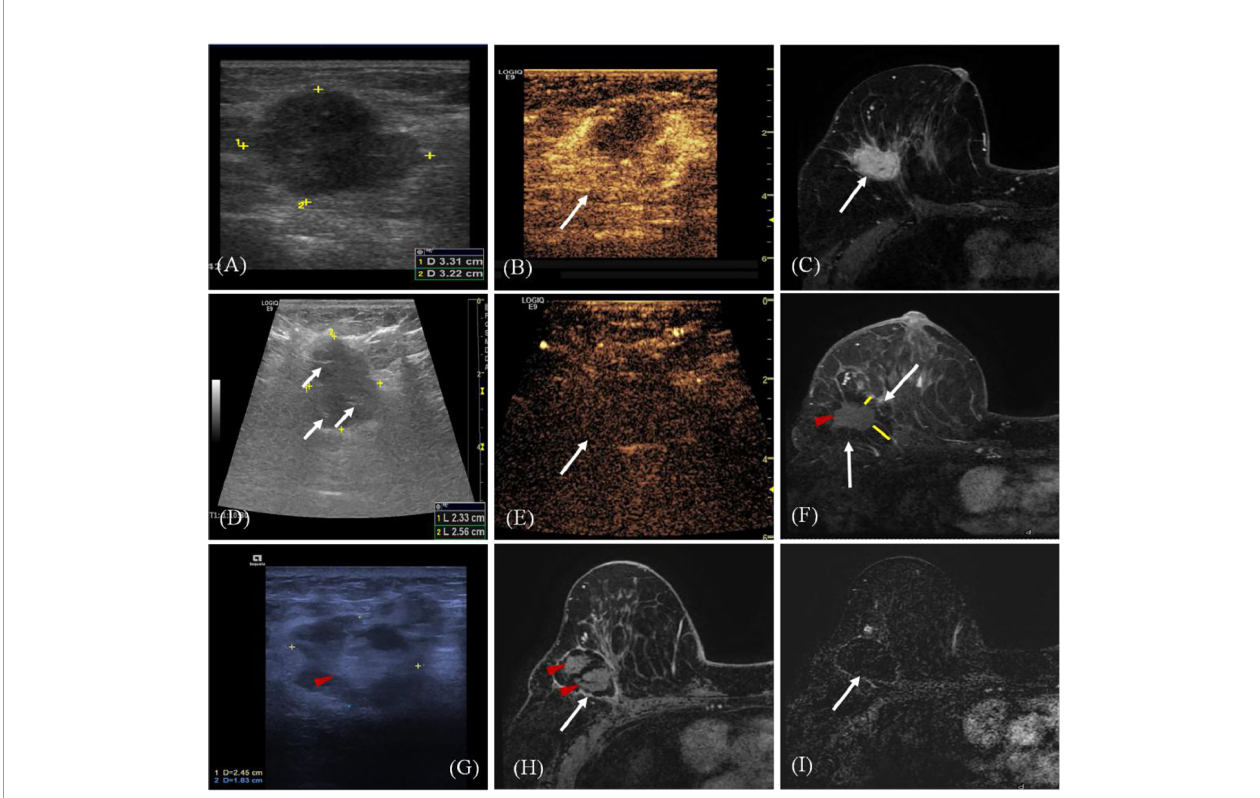
FIGURE 2 | A 68-year old woman with invasive ductal carcinoma of the right breast. (A) Ultrasound (US) scan before microwave ablation (MWA) shows the hypoechoic mass (arrow) with size of 3.3 cm × 3.2 cm. (B) Contrast-enhanced US before MWA shows the mass is hyper-enhanced (arrow) in arterial phase. (C) Transverse contrast-enhanced magnetic resonance imaging (MRI) shows hyperintensity masses (arrow) before MWA in arterial phase. (D) US scan shows the heterogeneously hypoechoic mass (marker) with size of 2.6 cm × 2.3 cm immediately after MWA (ghost size). Hyperechoic needle tracts can be seen in the ablated mass (arrow). (E) Contrast-enhanced US immediately after MWA shows the mass is non-enhanced (arrow) in arterial phase. (F) Contrast-enhanced MRI image shows hyperintensity ghost of mass (red arrow) and the peripheral hypointensity treatment zone (white arrow) in arterial phase three days after MWA. The ablation margin is from 1.2 to 2.2 cm (yellow lines) which can be measured in the hospital information system. (G) US scan shows the heterogeneously ablation zone (marker) shrinks to the size of 2.5 cm × 1.8 cm at 18 months after MWA. Ghost of mass (arrow) is surrounded by hypoechoic adipose tissue. (H) Contrast-enhanced MRI image shows treatment zone (white arrow) is non-enhanced with clear capsule and the central hyperintensity ghost of mass (red arrow) in arterial phase at 18 months after MWA. (I) MRI silhouette shows no signal for the ablation zone with clear fi brous capsule and margin